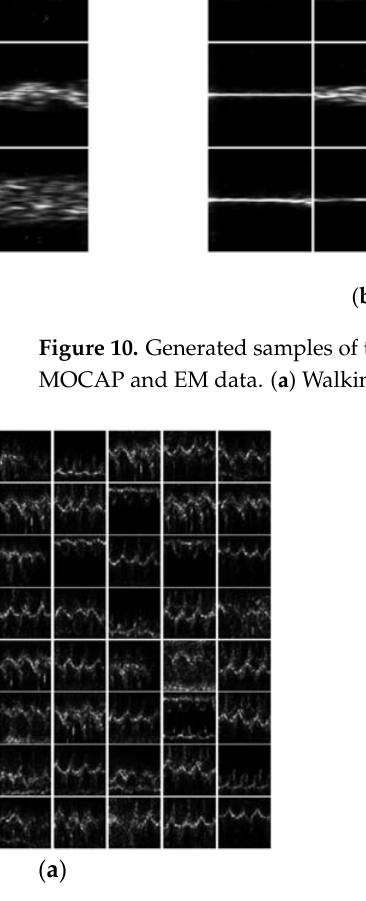
Figure 11. Generated samples of the measured pedestrian and vehicle target data. ( a ) Pedestrian; ( b ) vehicle.